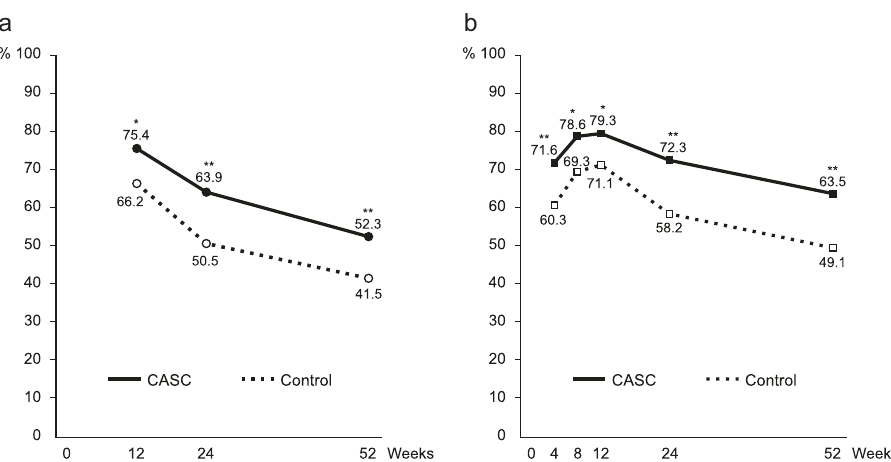
Fig. 3 Biochemically validated smoking abstinence rates. a Continuous abstinence rates from weeks 9 to 12, 9 to 24, and 9 to 52. b Seven- day point prevalence abstinence at weeks 4, 8, 12, 24, and 52. * P < 0.05, ** P <